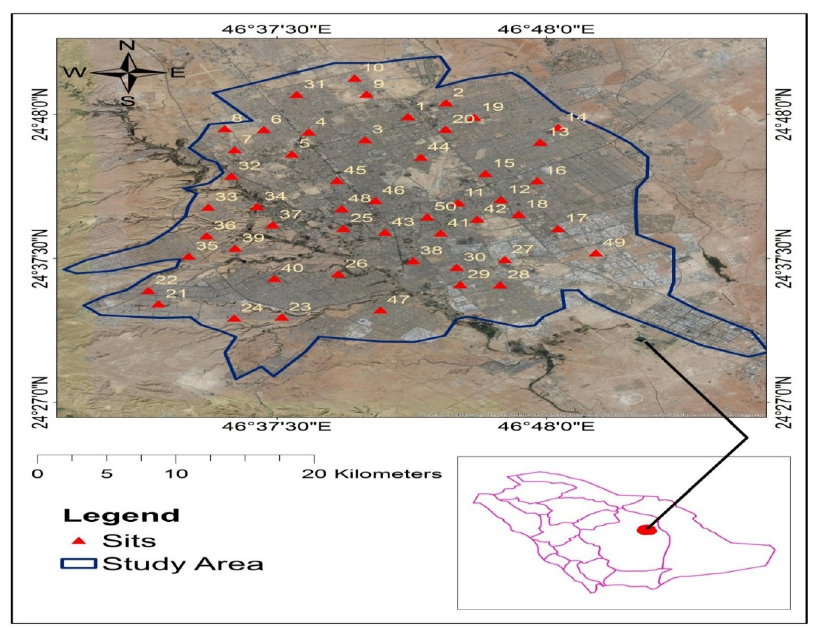
Fig 1. Air dust sampling